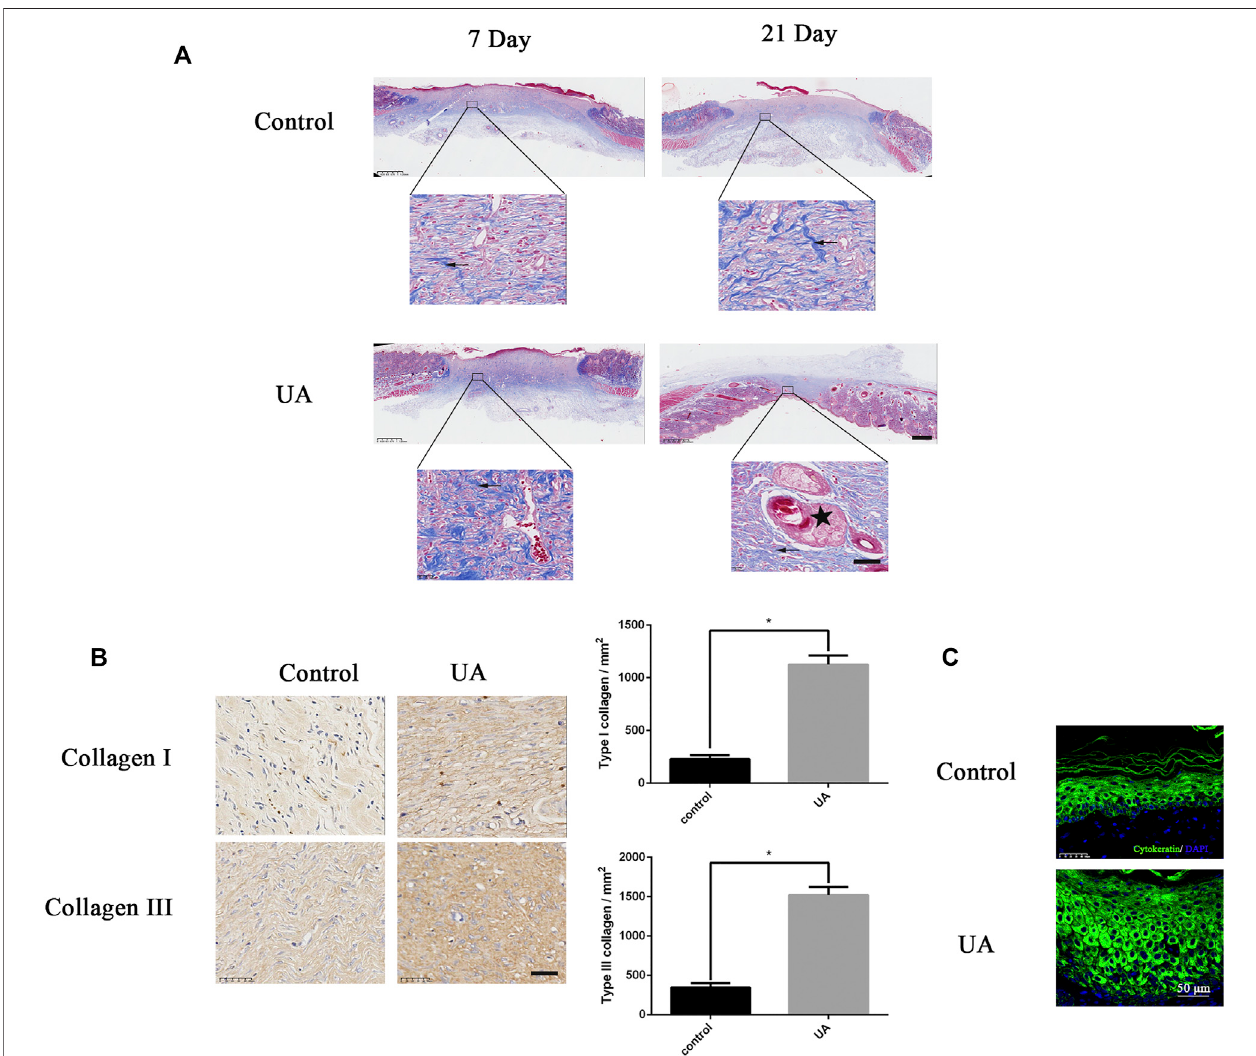
FIGURE5| UAincreasescollagensynthesisandcytokeratin. (A) Massontrichromestainingofwoundtissueonthe7thand21stdaysafterUAtreatment(scalebar = 100 μ m, 50 μ m). Arrows represent collagen deposition, and the fi ve-pointed star represents keratinization. (B) Representative images of type I and type III collagen immunohistochemical staining on the seventh day after surgery (scale bar = 50 μ m). Statistics of immunohistochemistry experiments. (C) Representative fl uorescence image of cytokeratin at the edge of the wound (scale bar = 50 μ m). The data represent mean ± SD ( n = 3) (* p < 0.05).